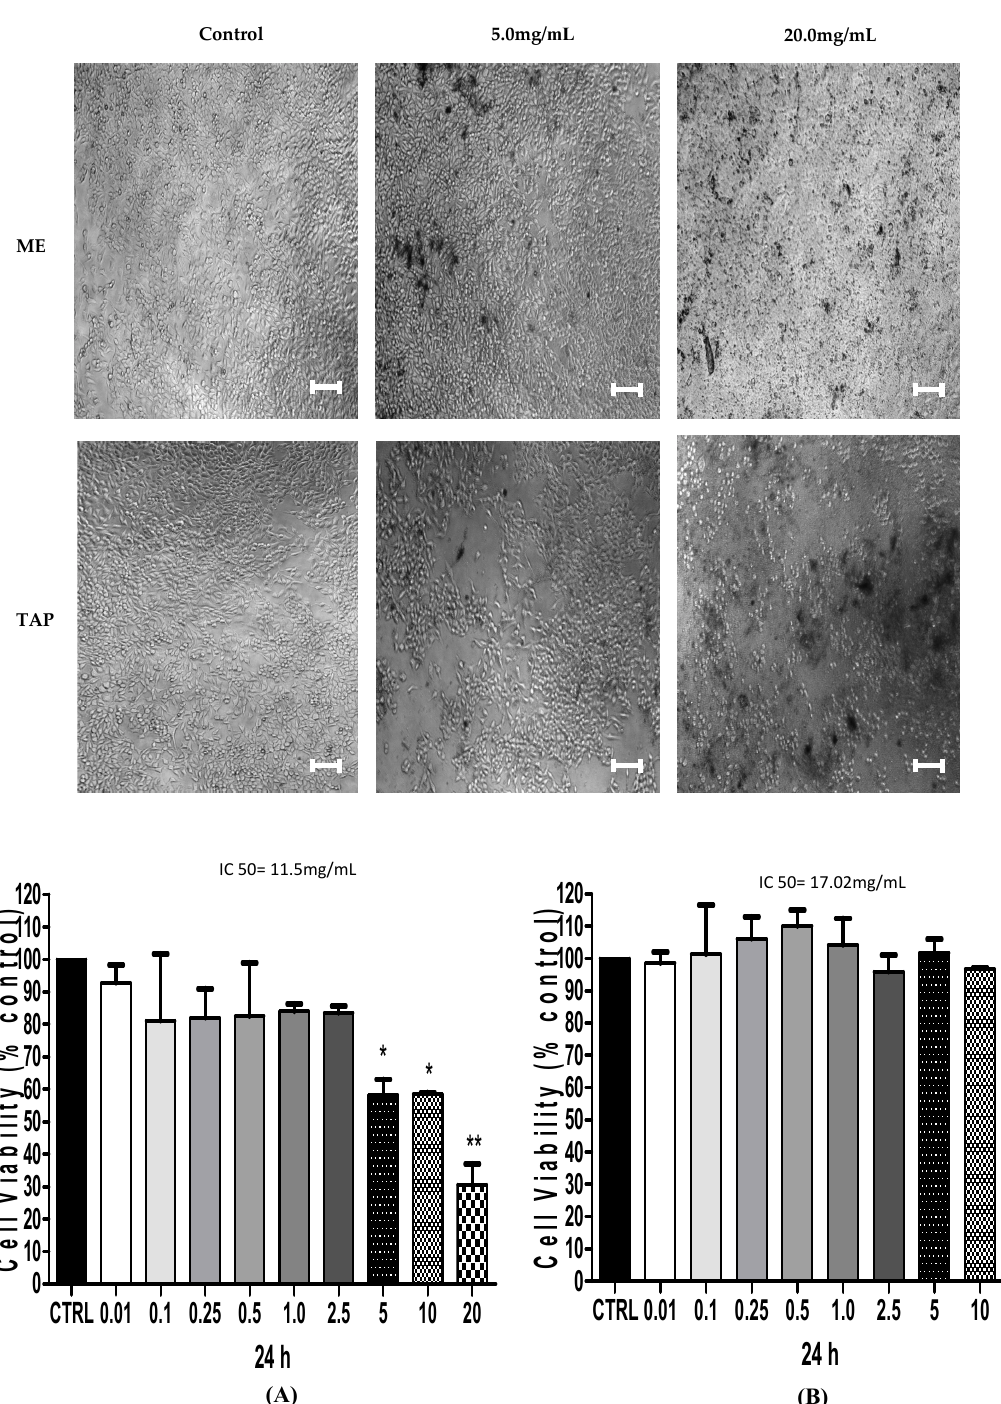
Figure 2. Effect of ME and TAP on ACRP cell viability. ME ( A ) and TAP ( B ) were tested for their effect on ACRP cell viability after 24 h of treatment using MTT assays. Significant differences between the untreated cells and those incubated with the respective extracts (0.01–20.0 mg/mL) were compared by one-way ANOVA followed by Tukey’s post-test (* p < 0.05; ** p < 0.01). Bar 100 µm.